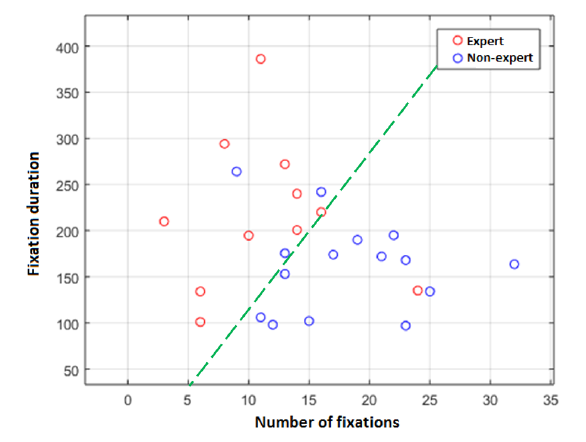
Figure 7. Distribution of the two features (number of clusters and average fixation duration for a cluster) for a group of experts and